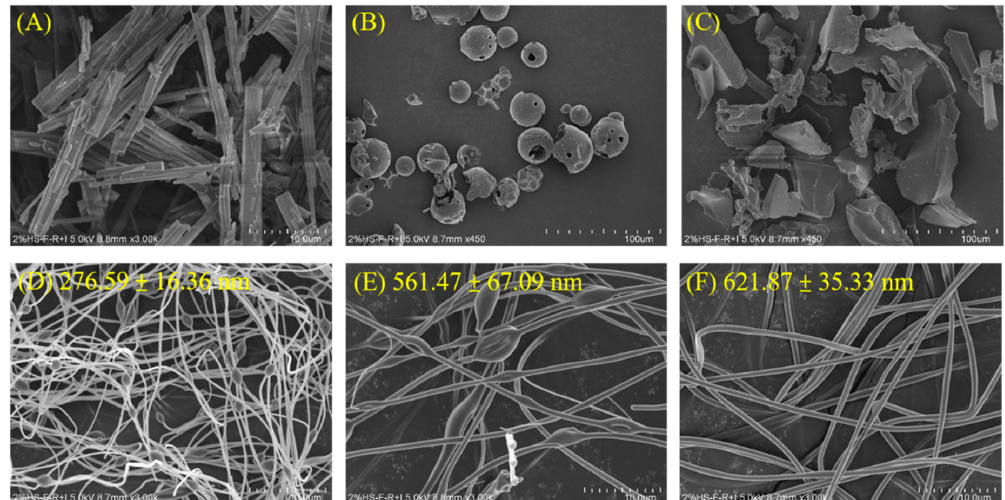
Figure 2. SEM images showing the surface morphology of ( A ) pure MYR, ( B ) pure HPBCD, ( C ) pure PVP, ( D ) MyNF 1:20:4, ( E ) MyNF 1:20:8, and ( F ) MyNF 1:20:12.